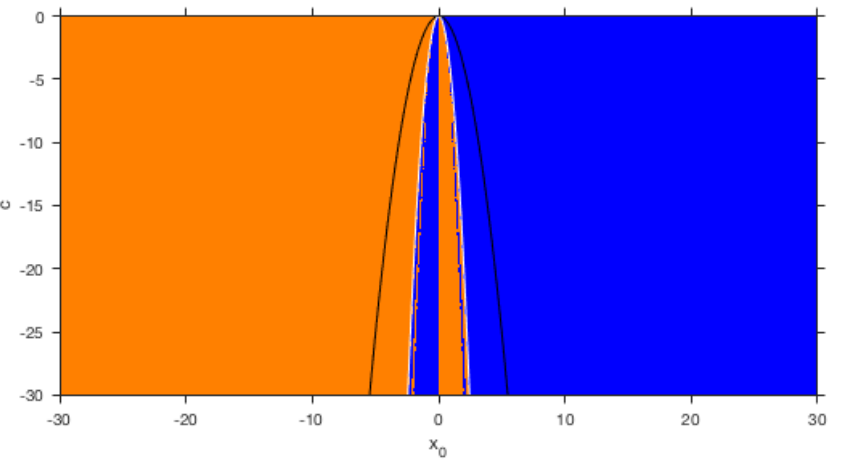
( c ) orange, x F ( c ) blue, no convergent 2 1